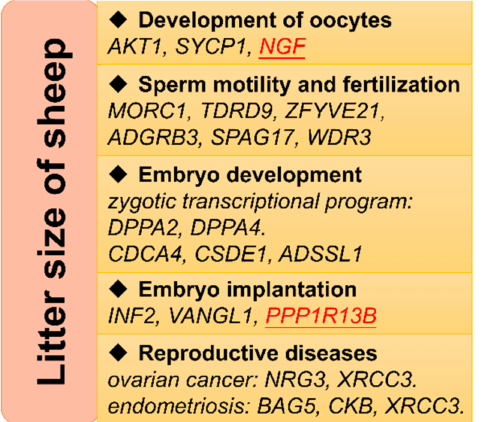
Figure 4. Some possible biological processes, by which candidate genes influence litter size in sheep. The underlined genes in red have been reported to be associated with litter